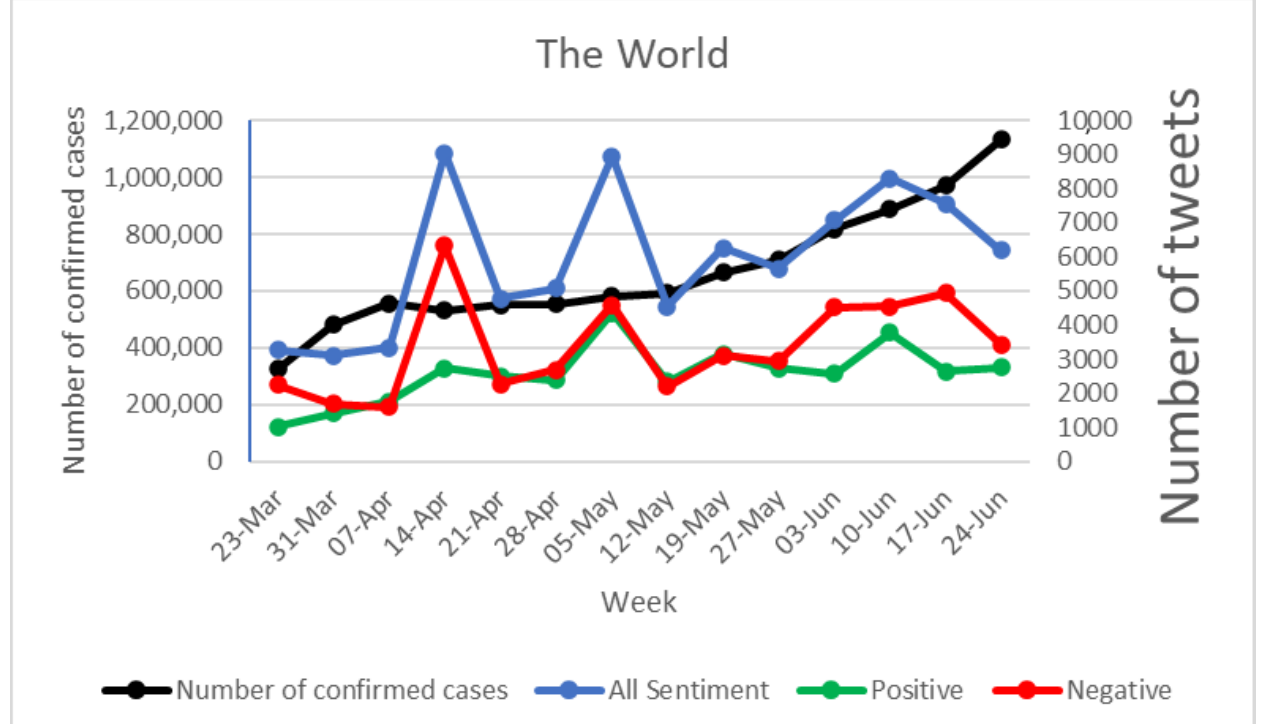
Figure 5. Frequency of all, positive, and negative tweets, and the official COVID-19 cases for the whole world.